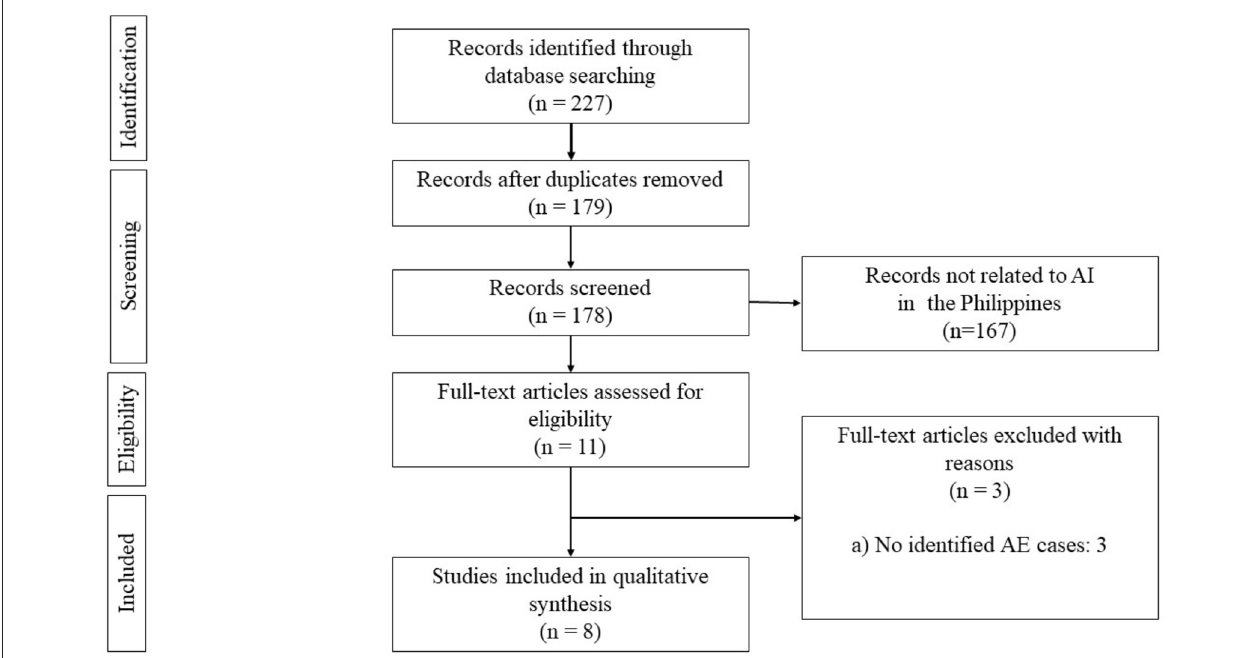
FIGURE 1 | Flow diagram adapted from PRISMA guidelines for scoping